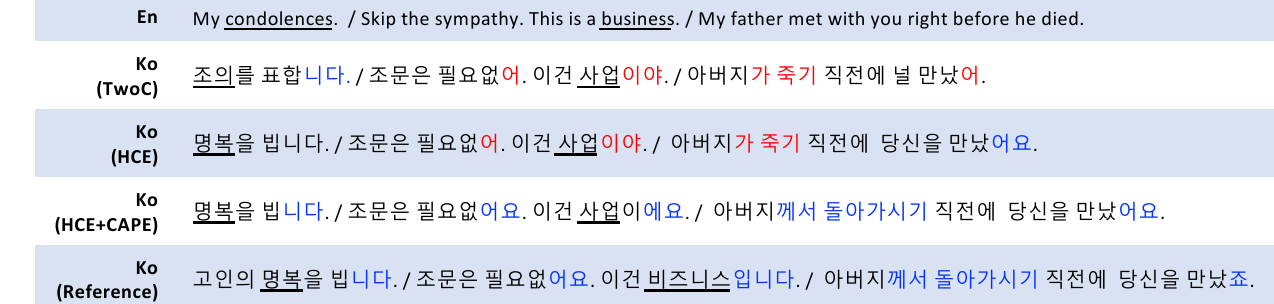
Figure 9. Example of a translation made by HCE and its correction by CAPE. The second and third sentence segments are the utterance of the same speaker. HCE’s translations are inconsistent in honorifics since honorifics of the second and third segments do not agree. The CAPE successfully corrected that inconsistency. Note that CAPE also fixed the subject honorification, resulting in a more polite translation. Note that the underlined nouns are differ among models, despite that all the translations have the same